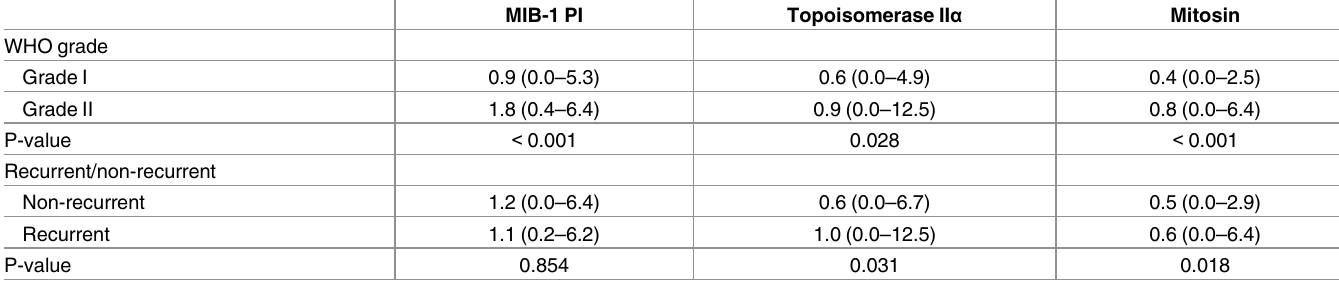
Table 2. Differencesin proliferation indices (PIs) between WHO grades and recurrent/non-recurrent meningioma.